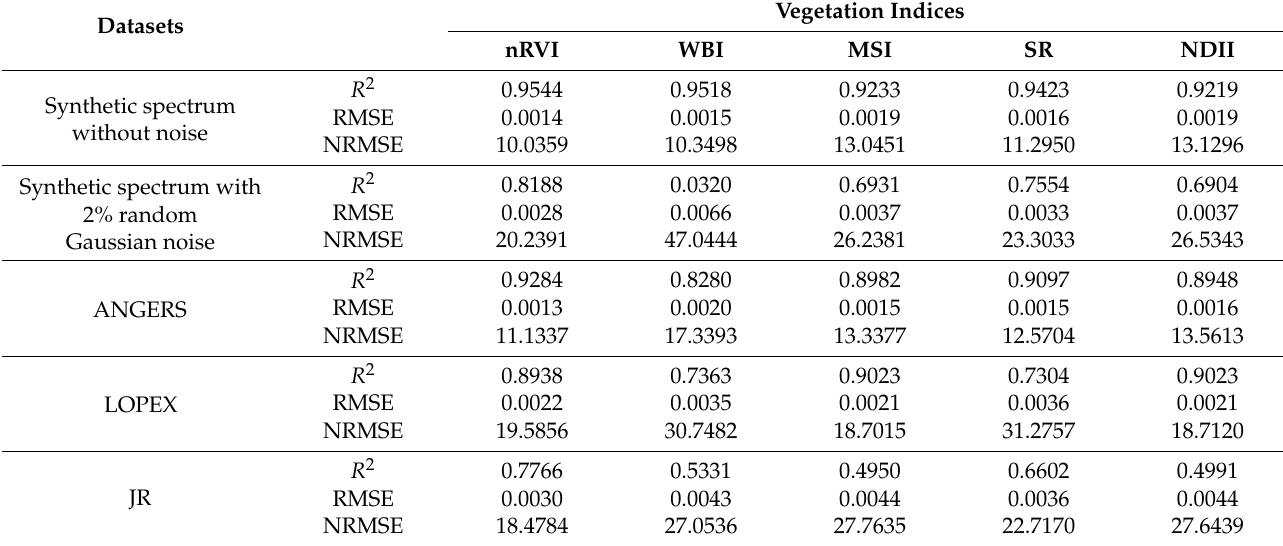
Table 6. Evaluation of VIs for EWT estimation with different datasets by using